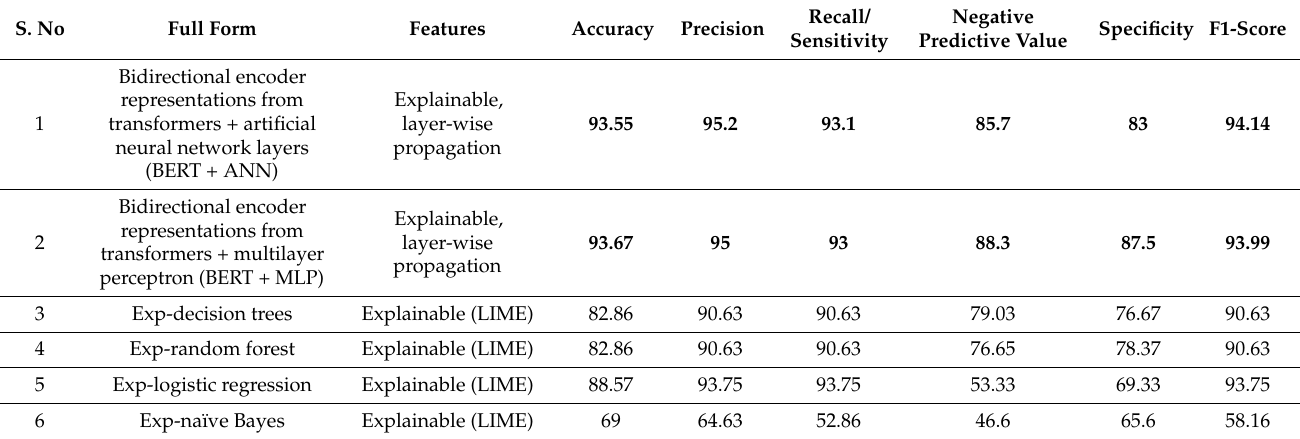
Figure 11. Result summary of all models on the HateXplain dataset. Table 8. Results of models on the HateXplain dataset.